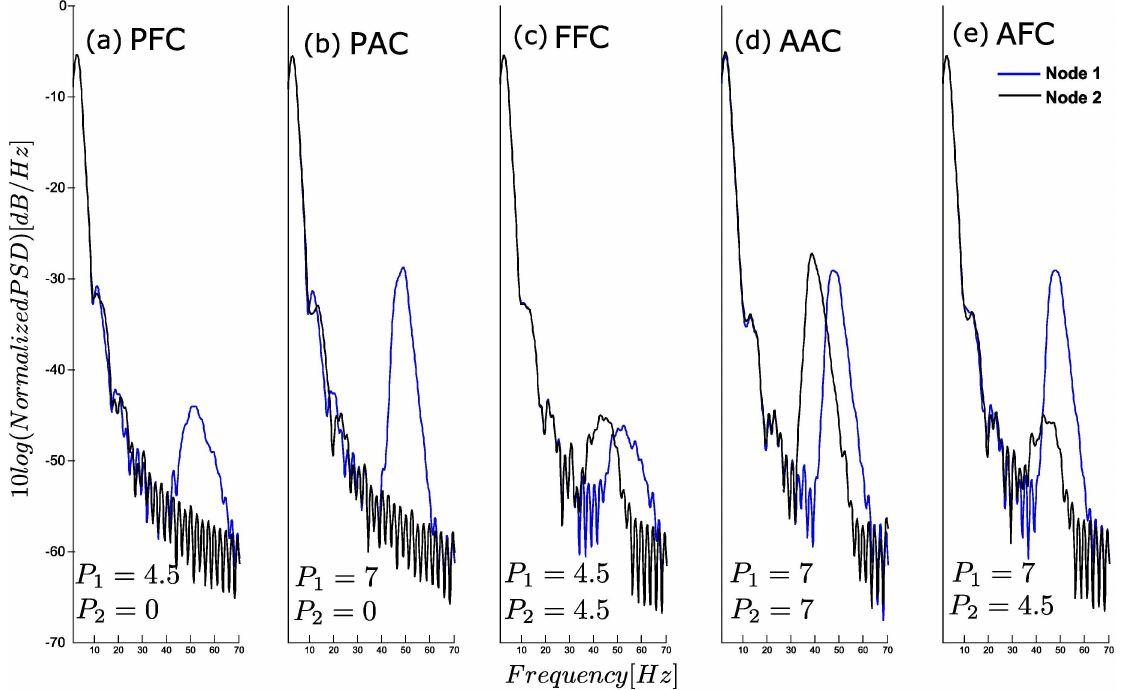
Fig 7. The comparison of PSDs in different forms of CFC. PFC: Phase-Frequency Coupling, PAC: Phase-Amplitude Coupling,FFC: Frequency-FrequencyCoupling,AAC: Amplitude-AmplitudeCoupling, AFC: Amplitude-FrequencyCoupling.